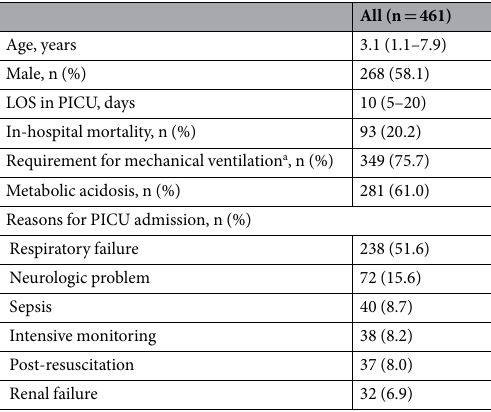
Table 1. Clinical characteristics of patients in PICU. Data are presented as number of patients (%) or median value (inter-quartile range). PICU, pediatric intensive care unit; LOS, length of stay. a Requirement for mechanical ventilation within 24 hours of PICU